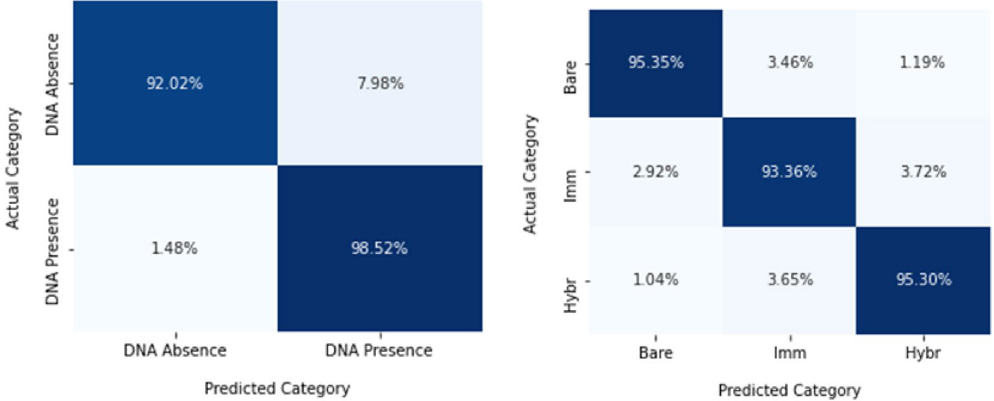
Figure 8. Normalized confusion matrix of RF classifier, DNA detection (Left) and DNA classification